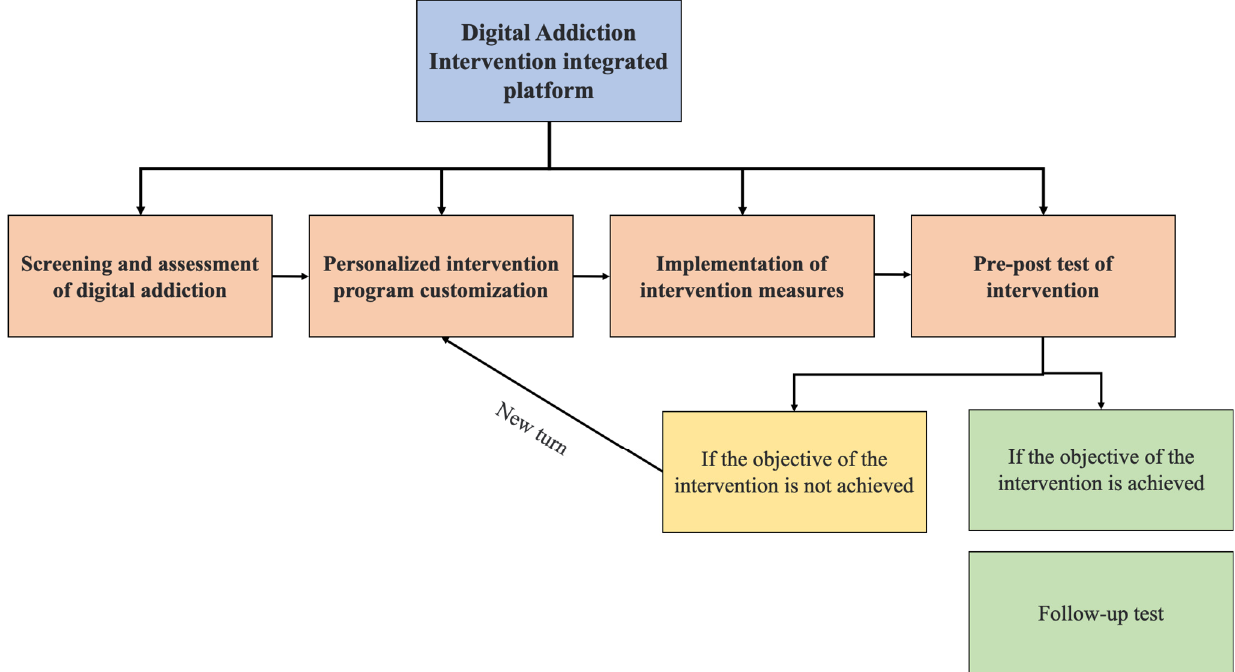
Figure 2. Schematic diagram of the Digital Addiction-integrated intervention platform. Blue represents the first level; orange represents the second level, divided into screening and assessment, intervention customization, intervention implementation, and pre-and post-testing; yellow and green represents the third level, green represents the achievement of the intervention objective, and re-evaluation the sustained effect of the intervention; yellow represents the failure to achieve the intervention objective, and the need for a new round of intervention.